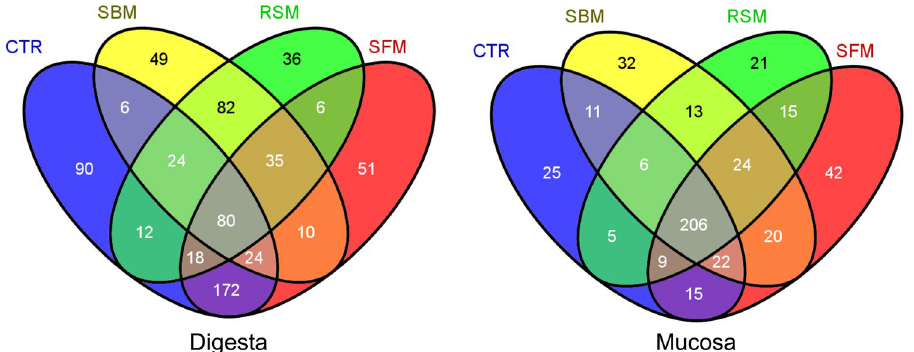
Figure 4. Venn diagram representation of shared and unique genera across the experimental feeding groups CTR (control fishmeal based diet), SBM (soybean meal based diet), RSM (rapeseed meal based diet) and SFM (sunflower meal, based diet), in Digesta and Mucosa samples, using Venny (https ://bioin fogp.cnb.csic.es/tools / venny _old/venny